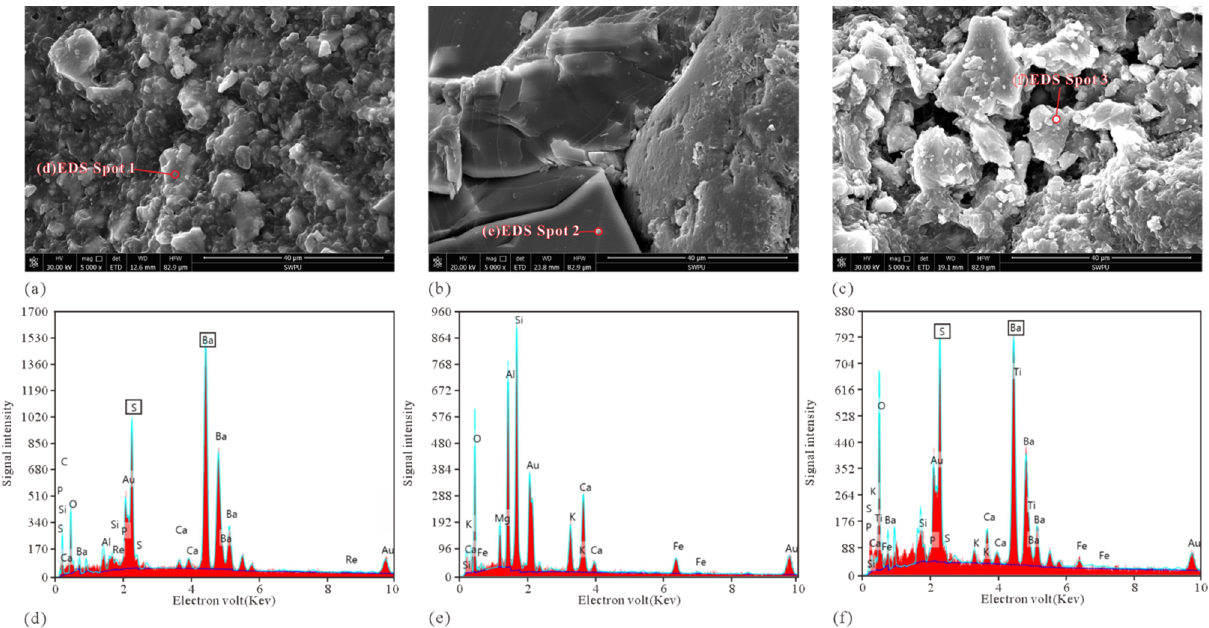
Figure 8. SEM image and energy spectrum analysis results: ( a ) SEM image of solid-phase composition of drilling fluid; ( b ) SEM image of the core sample before damage; ( c ) SEM image of the core sample after damage; ( d ) energy spectrum analysis result for solid composition of drilling fluid; ( e ) Energy spectrum analysis result of core sample before damage; ( f ) Energy spectrum analysis result of the rock sample after damage.